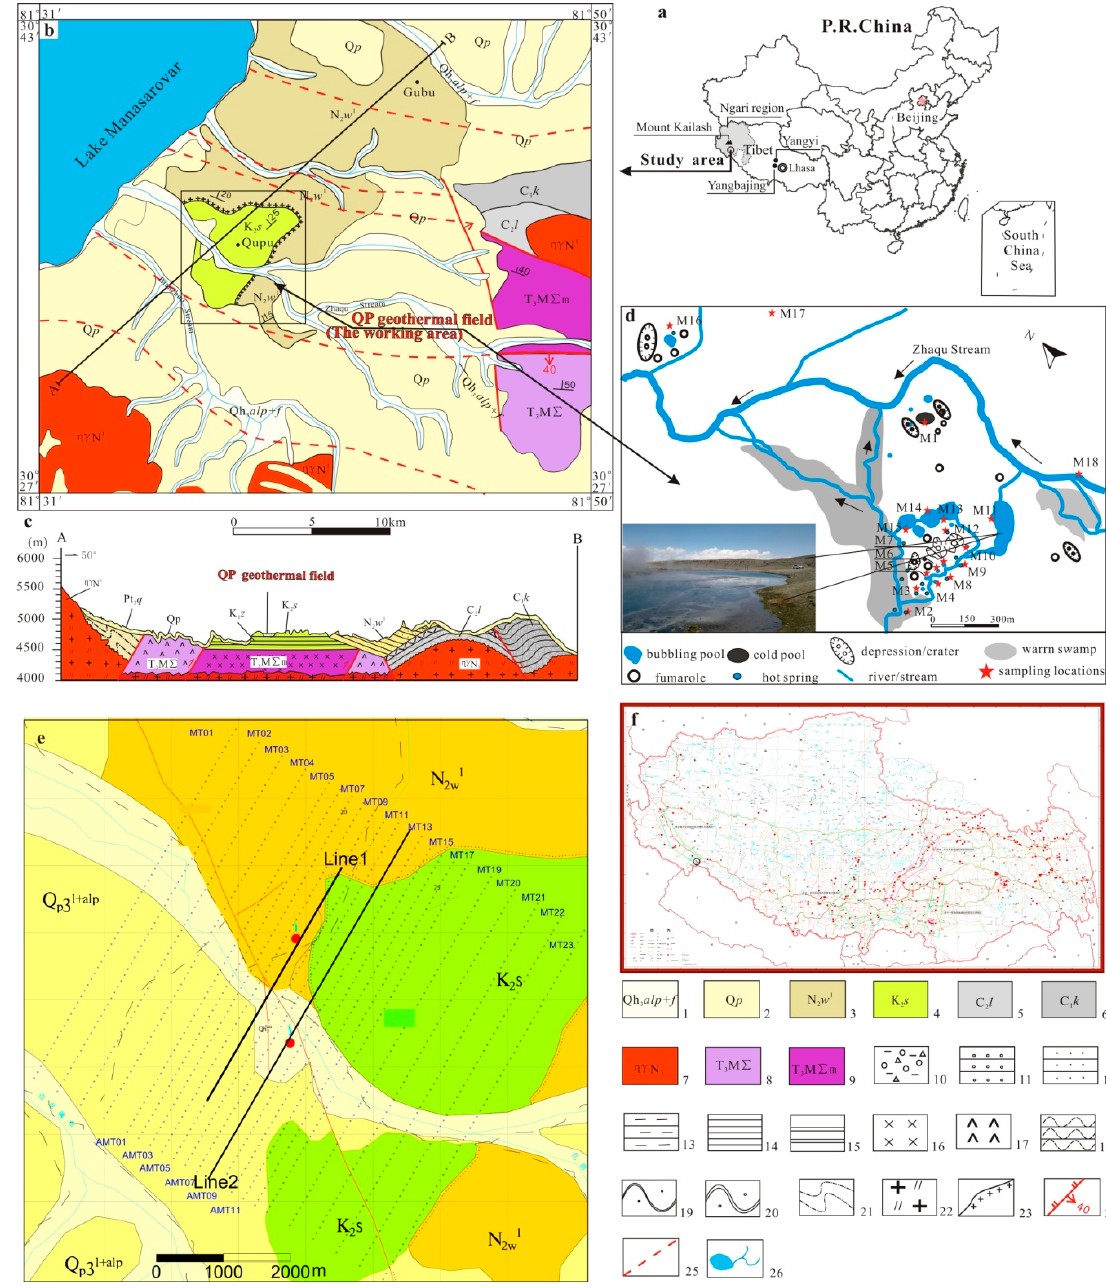
Figure 2. Location of the QP geothermal field and field layout of AMT and MT survey. ( a ) Location of the QP geothermal field; ( b ) its geological setting; ( c ) cross section; ( d ) locations of geothermal features; ( e ) the local geological map showing field layout; and ( f ) the location of the hot springs in Tibet (modified from Wang et al. [17], with permission from the authors). Line1 and Line2 show the location of the section of Figures 3 and 4. Numerals: ( 1 ) Late Holocene alluvial ‐ proluvial fan; ( 2 ) Pleistocene deposits; ( 3 ) Lower Member of the Neocene Woma Group; ( 4 ) Upper Cretaceous Sangdanlin Formation; ( 5 ) Upper Carboniferous Lasha Formation; ( 6 ) Lower Carboniferous Kangtuo Formation; ( 7 ) Neocene monzogranite granite; ( 8 ) Upper Triassic mafic rocks; ( 9 ) Upper Triassic complex; ( 10 ) Quaternary sediment; ( 11 ) conglomerate; ( 12 ) sandstone; ( 13 ) mudstone; ( 14 ) shale; ( 15 ) siliceous rock; ( 16 ) complex rock; ( 17 ) mafic rock; ( 18 ) phyllite; ( 19 ) meta ‐ sandstone; ( 20 ) metamorphic conglomerate; ( 21 ) mylonite; ( 22 ) monzogranite; ( 23 ) boundary of an unconformity; ( 24 ) reverse fault; ( 25 ) buried fault; and ( 26 ) stream or lake.